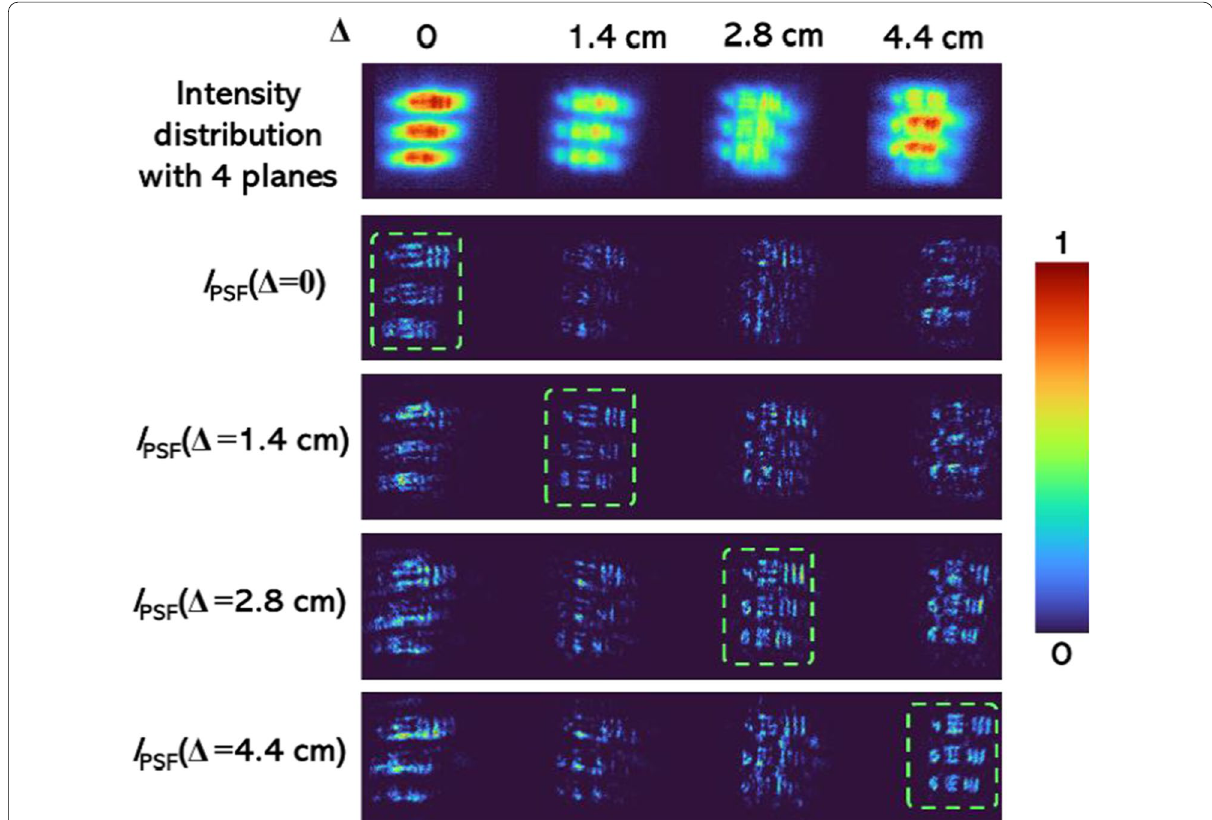
Fig. 10 Output images of the system in response to the resolution chart in the input, and reconstruction results using I PSF recorded at the respective planes of the